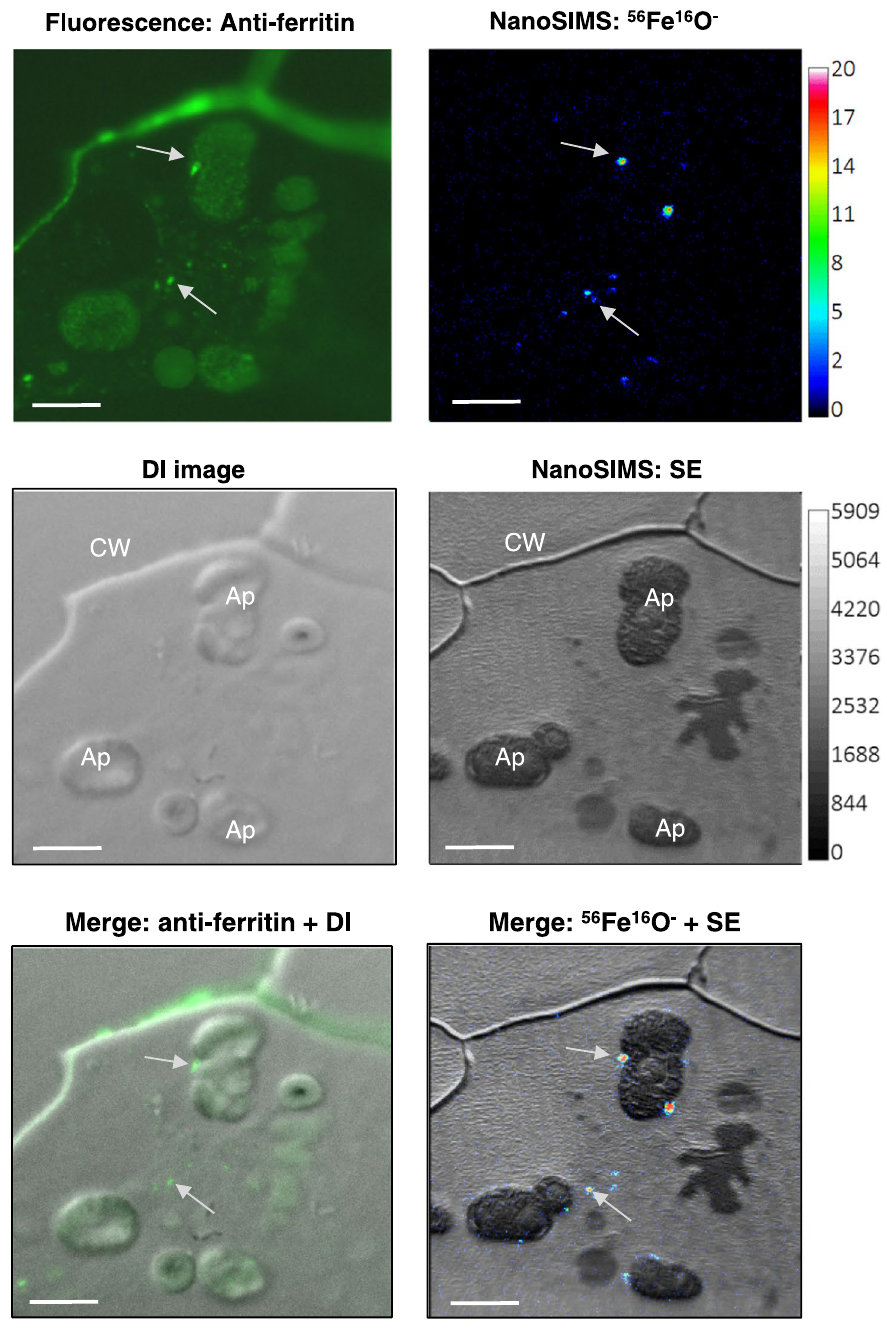
Figure 4. Corresponding localization of iron and ferritin protein. Adjacent thin sections of cotyledons from immature pea seeds (JI1194) at 22–24 DAF were labelled with antibodies against pea ferritin followed by Alexa- Fluor conjugated secondary antibodies (top left, green) or imaged for 56 Fe 16 O − ions using NanoSIMS (top right, with colour scale for the intensity of the signal). The differential interference (DI) image of the immunolabelled section and the secondary electron (SE) image for NanoSIMS show the cell walls and organelles. CW, cell wall; Ap, amyloplast. The images are representative of 2 different regions for which 2 cells each were